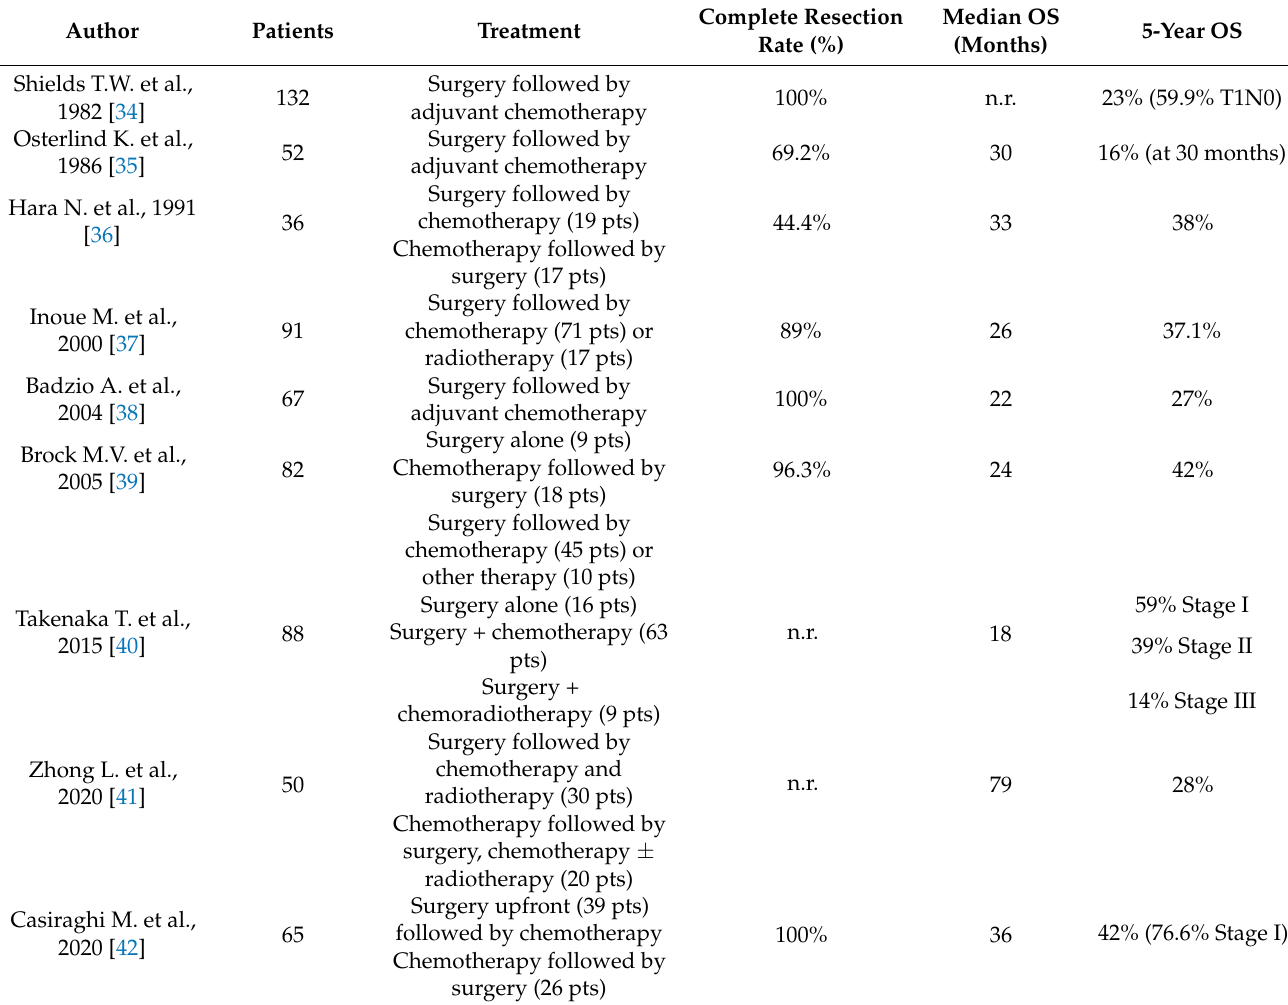
Table 3. Retrospective trials evaluating the role of